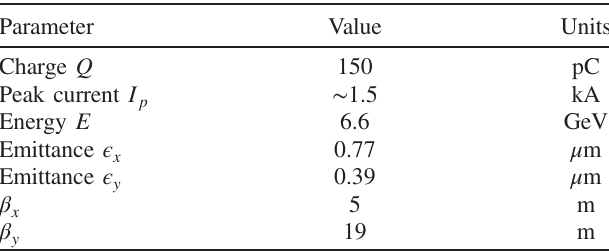
TABLE II. Beam parameters for proposed dechirper experi- ment.